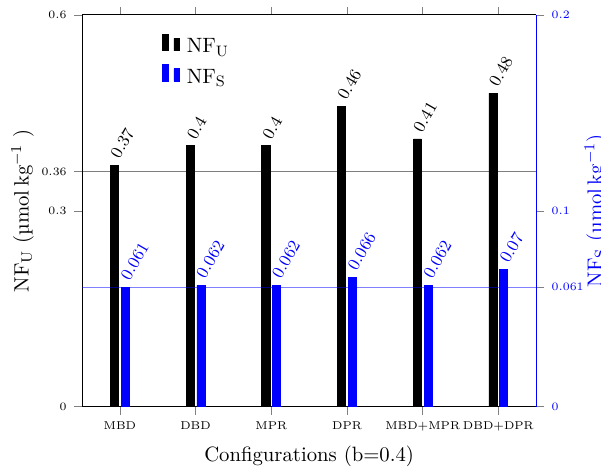
Figure 7. Sensitivity of simulated steady-state concentrations of ni- trogen fixers (NF U and NF S ) in the U and S boxes, respectively, after applying b = 0 . 4 for Eq. (2). Horizontal grey and light blue lines represent the NF U and NF S concentrations in the control con-